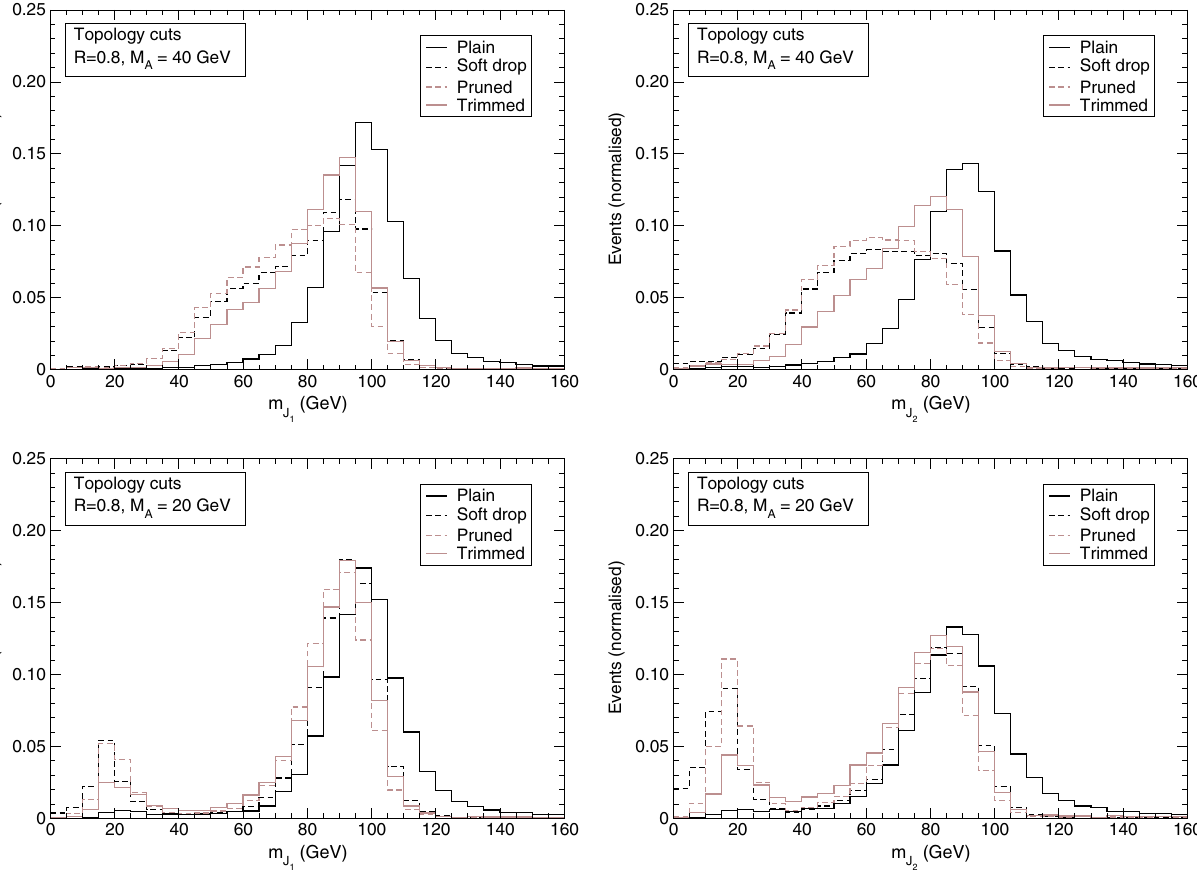
Fig. 17 Jet mass distributions for R → SS and different grooming algorithms, for jet radius R = 0 .